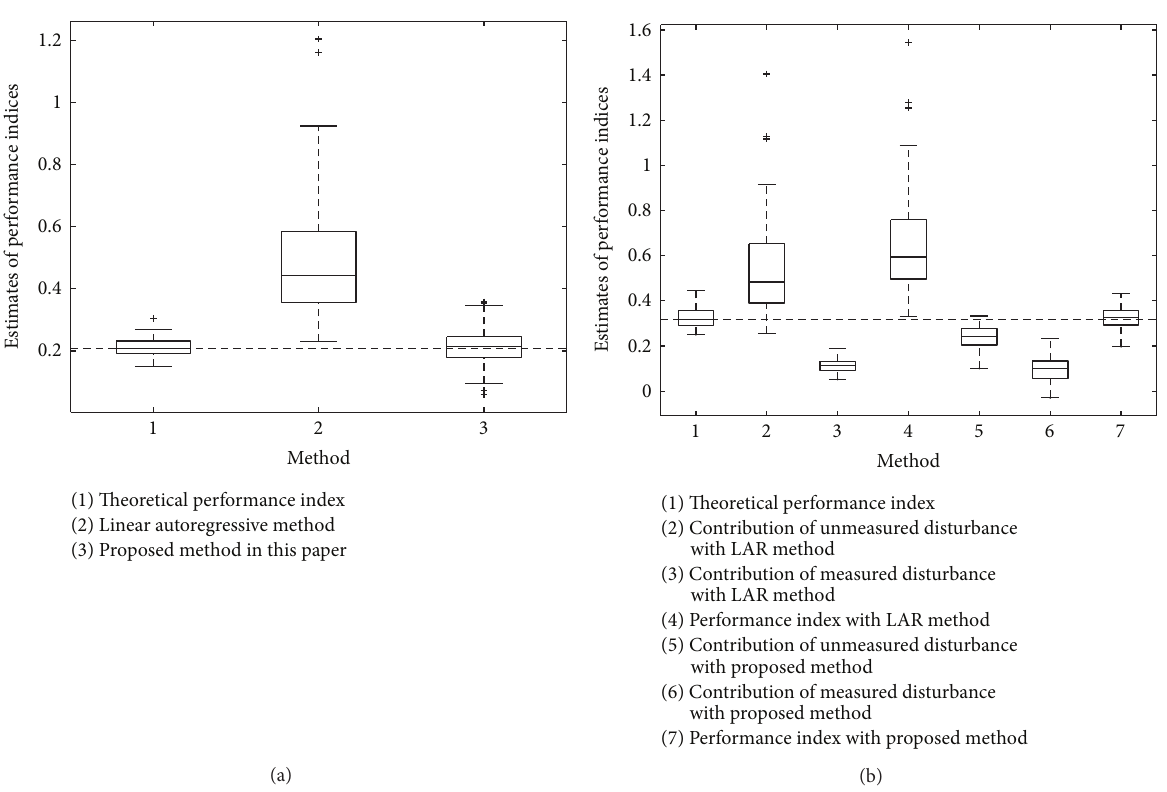
Selecting an appropriate memory length of 40 and